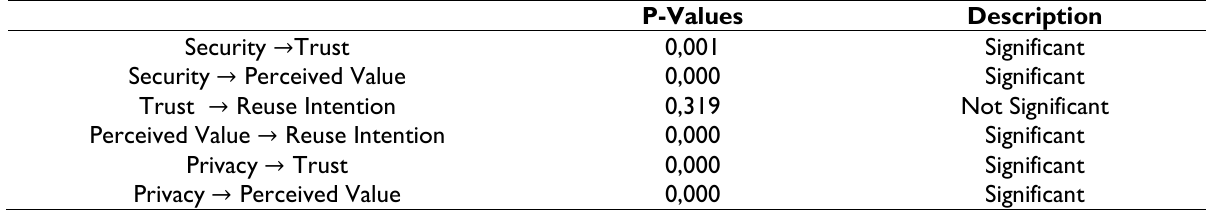
Table 5. P-Values